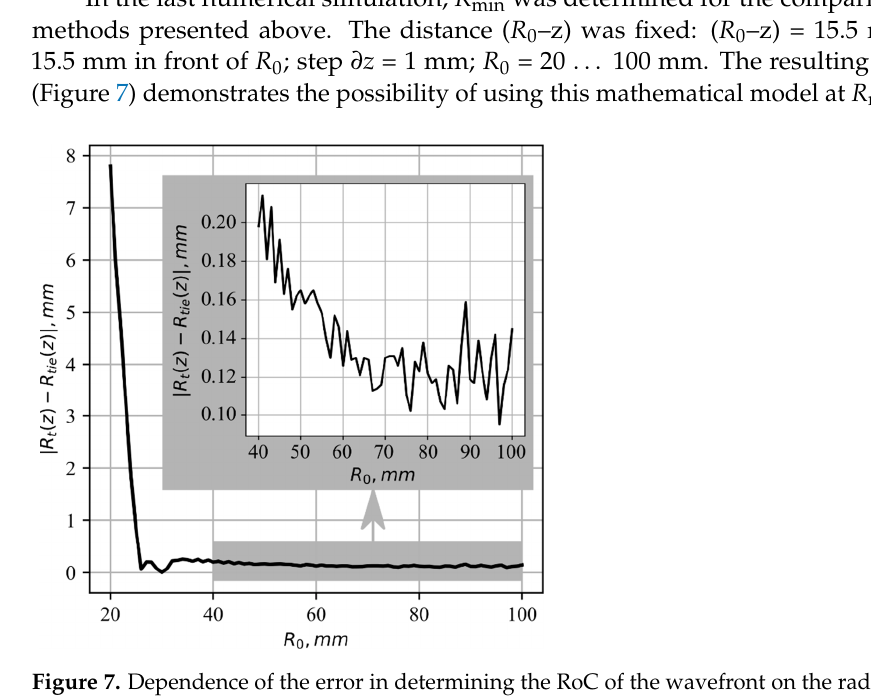
Figure 6. Dependence of the error in determining the RoC of the wavefront on the ∂ z = 0.1; 1; 5; 10 mm. Note that it is difficult to find the exact value of the chord l near R 0 due to the effect of sampling. So, at z = 97 mm the chord l = 5 px, and the values in these 5 pixels differ from each other by 4 ∙ 10 2 (for I max ( z = 0) = 1.0). That is, to improve the accuracy in the region z ≅ R 0 , interpolation is necessary, which will allow obtaining a more accurate value of the chord l .